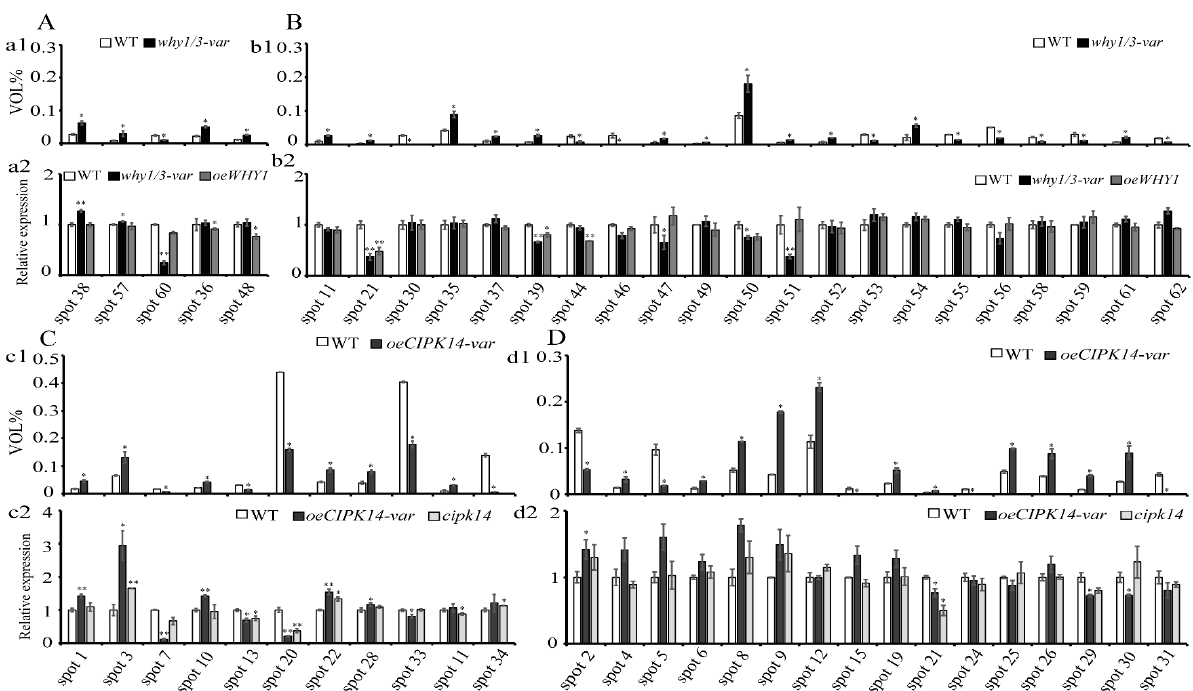
Figure 5. Comparison of changes in the protein and mRNA levels for selected protein spots. The relative protein abundance is represented by percent volume. ( A ) The mRNA levels change in parallel with protein levels in the why1/3-var lines; ( a1 ) The relative protein abundance of protein spots in the WT and why1/3-var ; ( a2 ) The relative expression levels of the corresponding genes in ( a1 ) are analyzed in the WT, why1/3-var , and oeWHY1 ; ( B ) The mRNA levels change independently in the why1/3-var lines; ( b1 ) The relative protein abundance of protein spots in the WT and why1/3-var ; ( b2 ) The relative expression levels of the corresponding genes ( b1 ) are analyzed in the WT, why1/3-var , and oeWHY1 ; ( C ) The mRNA levels change in parallel with protein levels in the oeCIPK14-var lines; ( c1 ) The relative protein abundance of protein spots in the WT and oeCIPK14-var ; ( c2 ) The relative expression level of the corresponding genes in ( c1 ) are analyzed in the WT, oeCIPK14-var , and cipk14 ; ( D ) The mRNA levels change independently in the oeCIPK14-var lines; ( d1 ) The relative protein abundance of protein spots in the WT and oeCIPK14-var ; ( d2 ) The relative expression of the corresponding genes in ( d1 ) are analyzed in the WT, oeCIPK14-var , and cipk14 . The relative expression level of the gene is normalized to GAPC2 , with the WT as 1. The error bars indicated standard error of three biological replications and three technique replicates. Asterisk indicate significant differences (* p < 0.05 and ** p < 0.01) based on Student’s t -test analyzed by Graphpad prism6